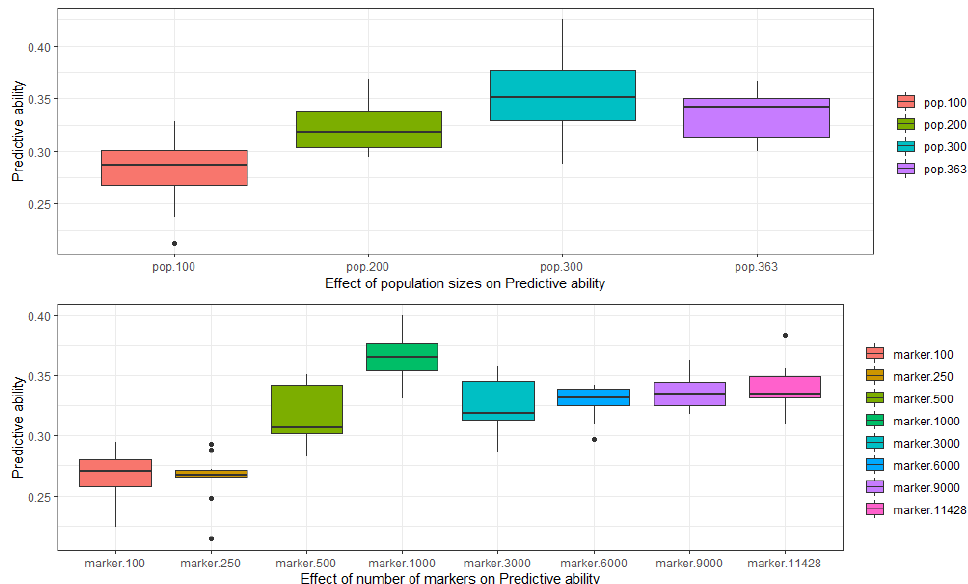
Figure 5. Effect of different population sizes and the number of markers on the predictive ability of genomic prediction.